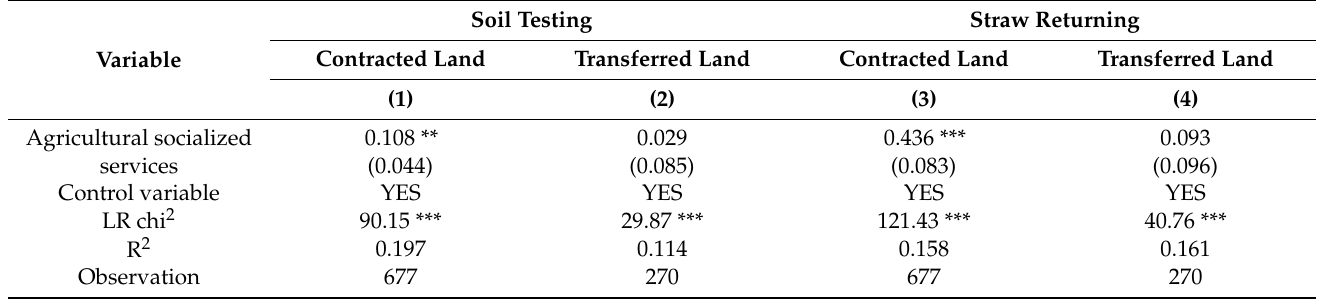
Table 5. Comparative analysis of contracted land transferred